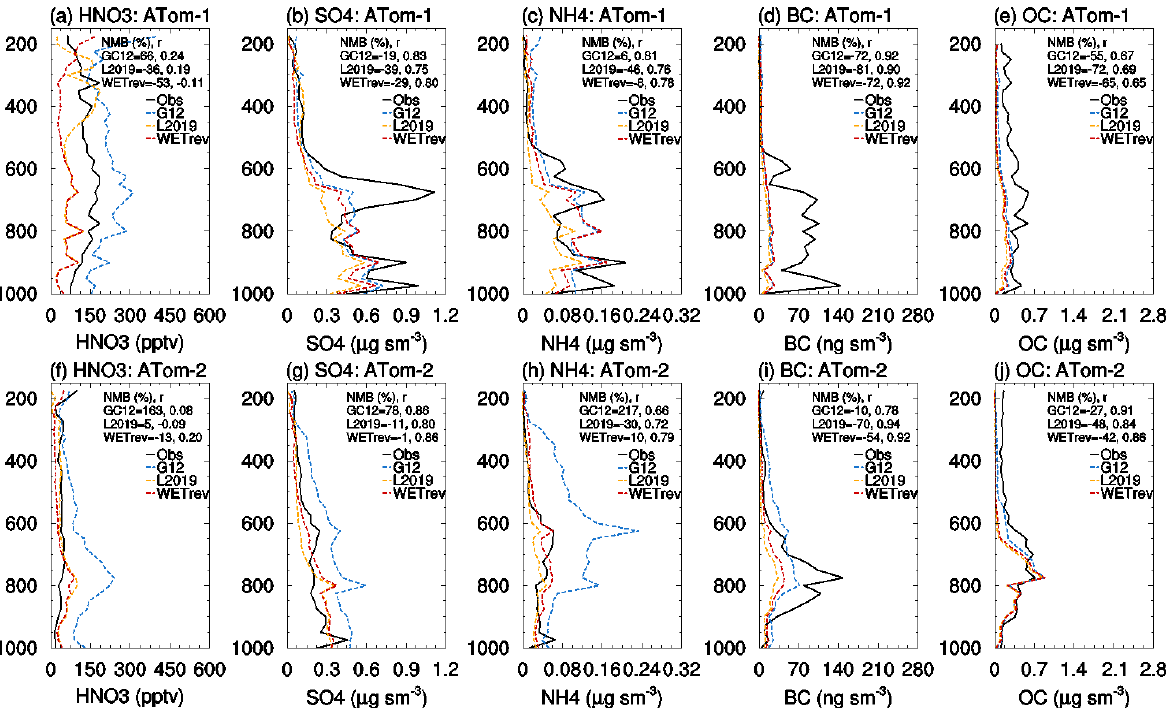
Figure 8. Vertical profiles of nitric acid, sulfate, ammonium, black carbon, and organic carbon from ATom aircraft observations (black, ATom-1: a–e ; ATom-2: f–j ) and GEOS-Chem simulations by GC12 (blue), L2019 (yellow), and WETrev (red) cases over the Northern Hemisphere.